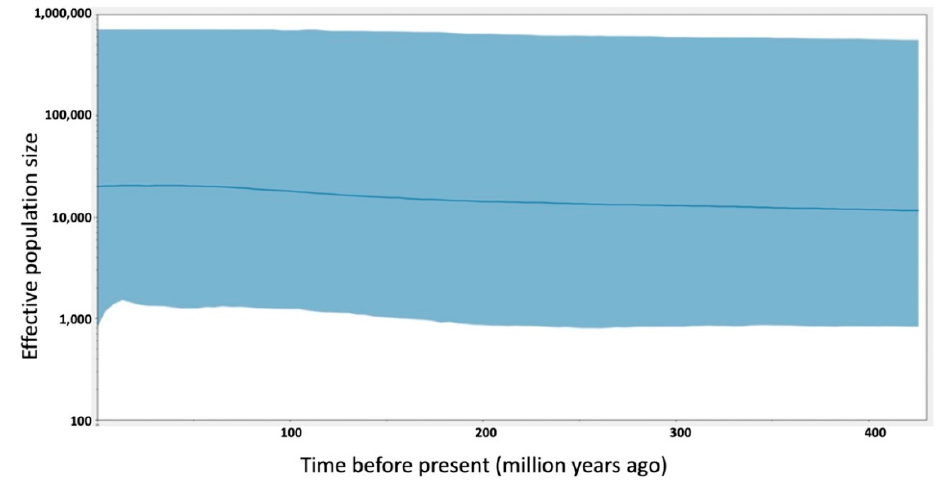
Figure 5. Bayesian Skyline Plots (BSPs) of effective population size over time of leatherback turtles in the Andaman Sea. The Y-axis indicates effective population size, X-axis indicates mean time in millions of years to the present, and the blue area represents the standard error.